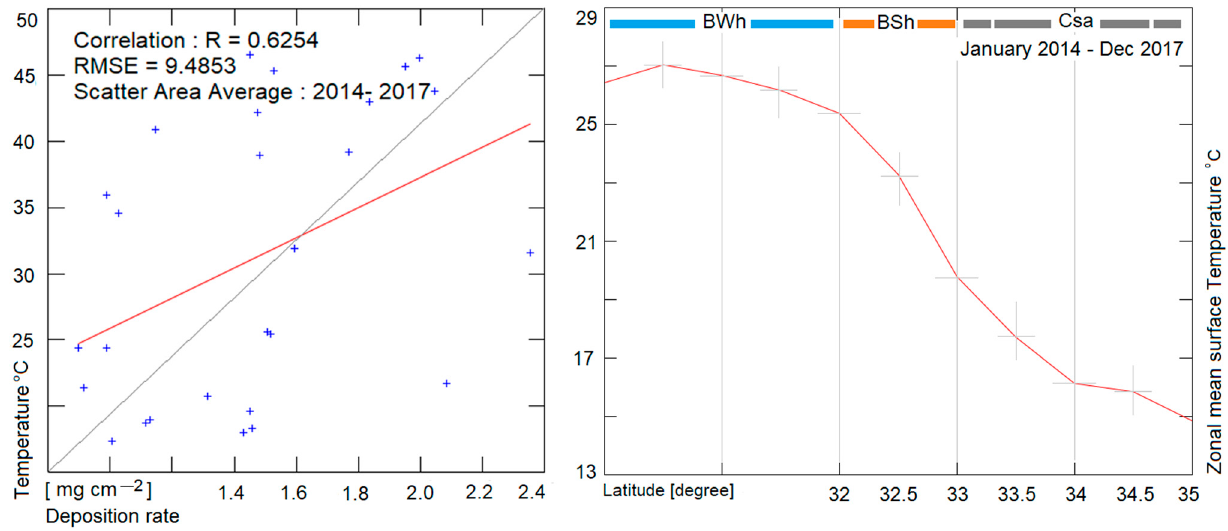
Figure 11. Correlation of surface temperature (°C) with eolian deposition rate (mg cm − 2 ). Left: correlation for temperature versus ground deposition rate (GDR) and Root Mean Square Error (RMSE), from 2014–2017. Right: Zonal means of surface temperature (°C) versus climate zones, as represented in narrow band at the top, wherein blue, orange, and gray represent BWh, BSh, and Csa, respectively).